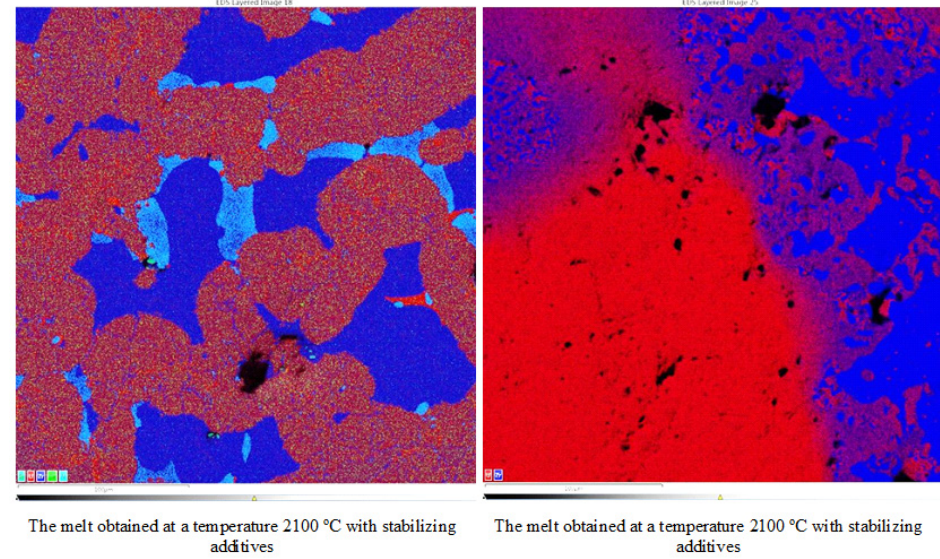
Figure 5. Results of SEM analysis in IAS.